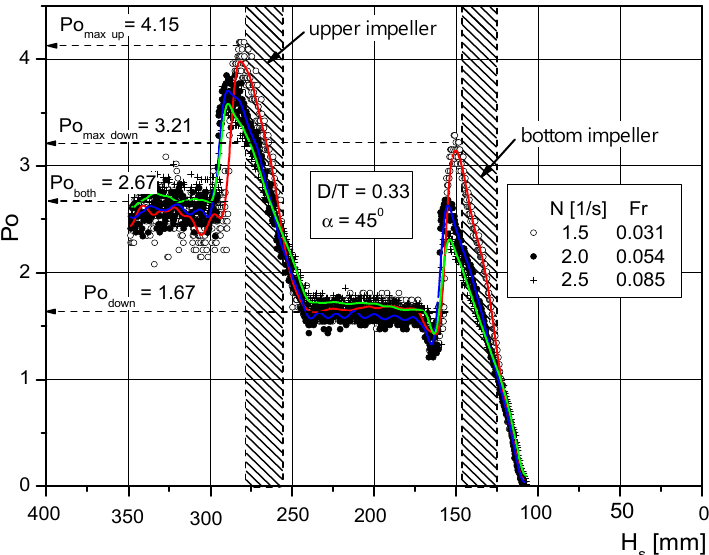
Figure 6. Changing the value of the power number Po when emptying the tank.